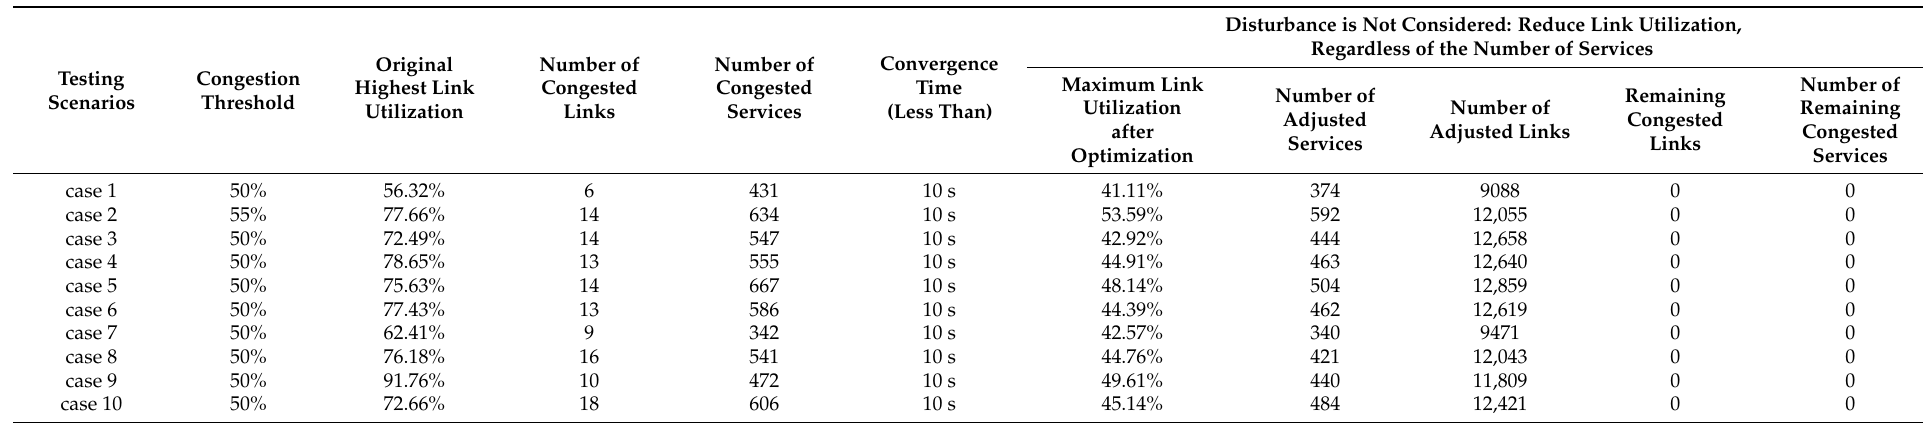
Table 7. Verification of traffic optimization based on load balancing strategies.